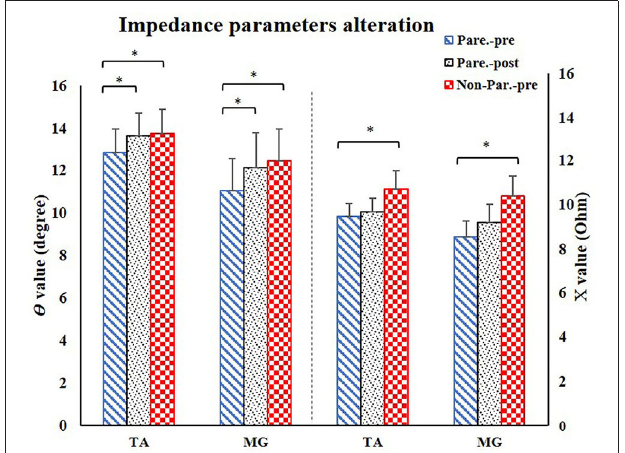
FIGURE 3 | EIM parameters alteration after training. For comparison between paretic and non-paretic muscles, there is a significant reduction of θ and X value in paretic TA and MG. After training, the paretic TA and MG both presented significant increase of θ value. TA, tibialis anterior; MG, medial head of gastrocnemius; X, reactance; θ , phase angle. * P < 0.05.